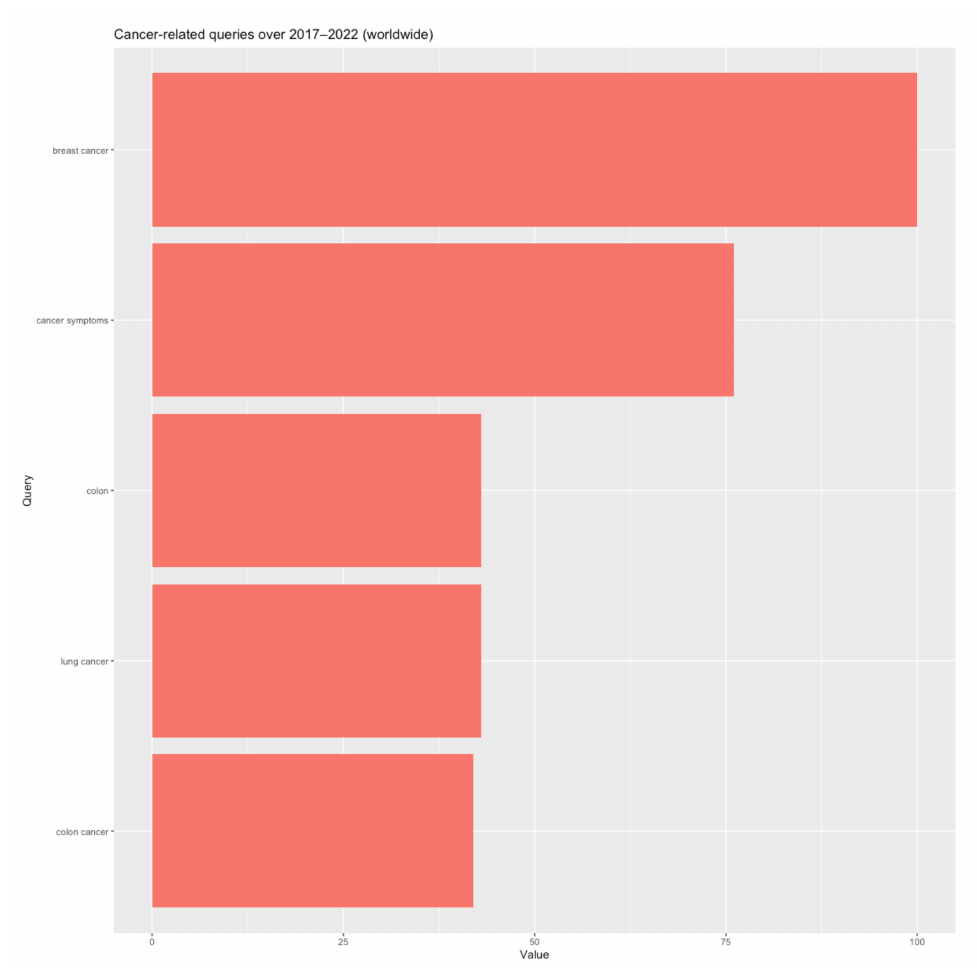
Figure 1. Most common queries related to the search term “cancer”: worldwide (April 2017– March 2022). Source of data: Google Trends. Estimation results using the “gtrendsR” package [19] in R